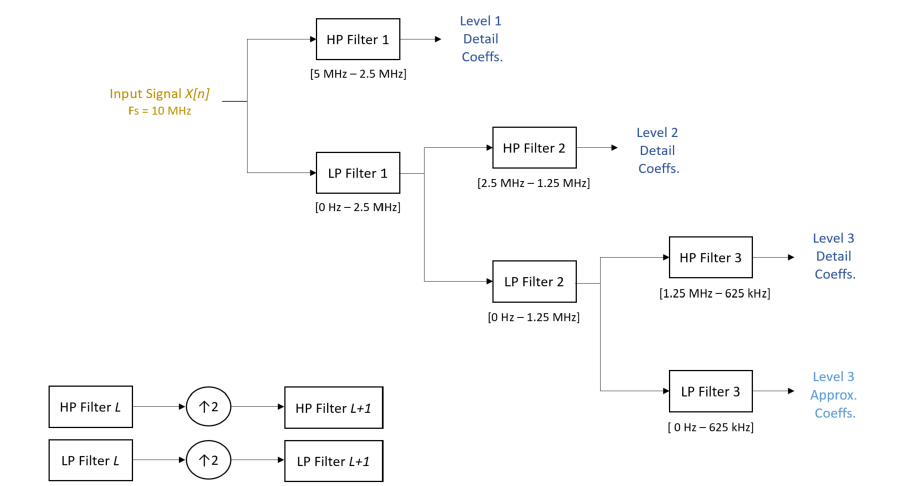
Figure 2. SWT decomposition filter structure.